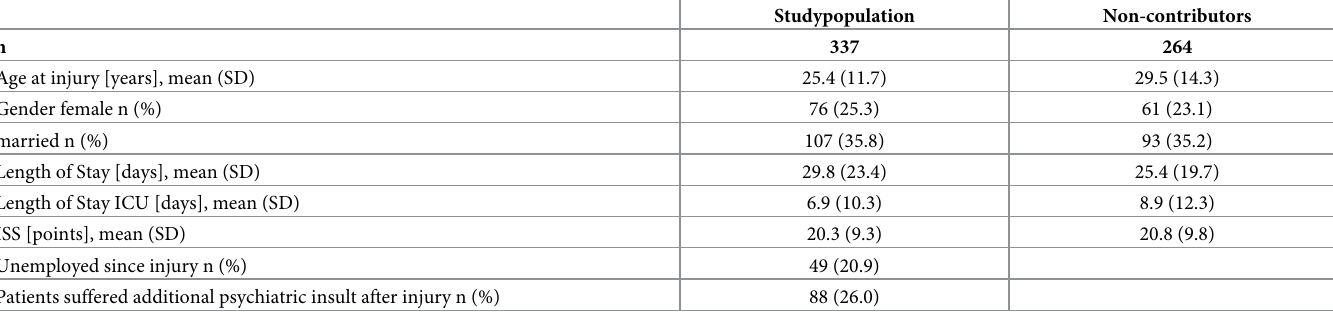
Table 1. Descriptive summary of demographics of study population.